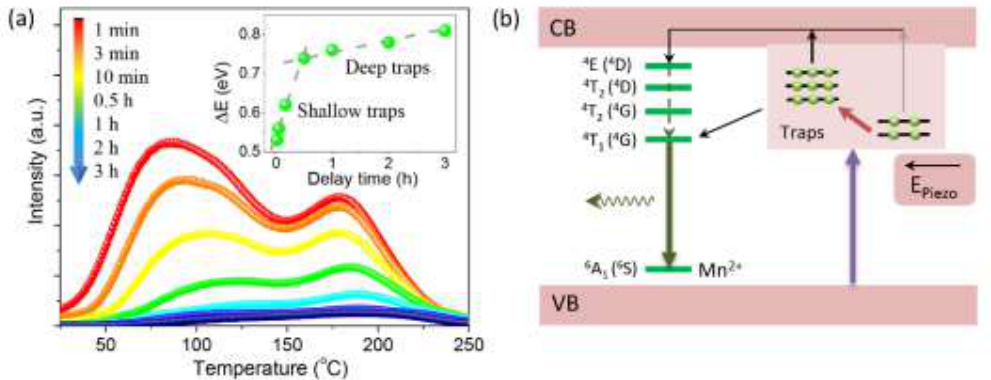
Figure 5. ( a ) ThL curves measured at different delay times. The inset plots the derived trap depth versus the delay time. ( b ) Schematic illustration of the proposed ML process, involving electron replenishment from deep traps to shallow traps.